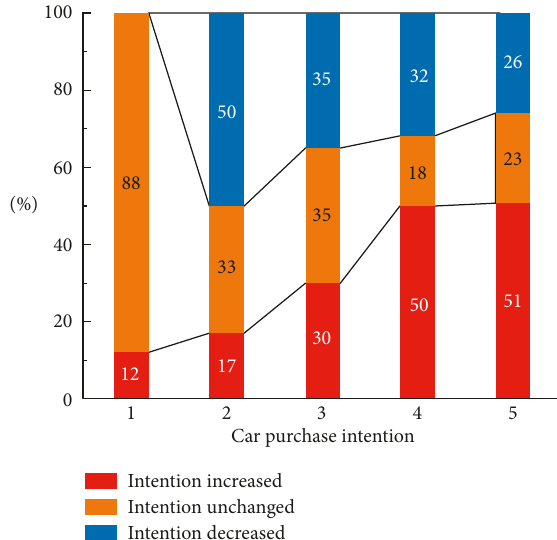
Figure 3: Statistics of pre-COVID-19 car purchase intentions and post-COVID-19 intention